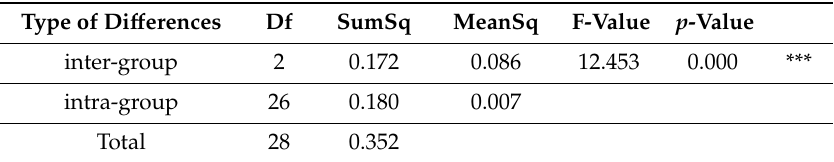
Table 8. Analysis of variance: CE ranking by income level.